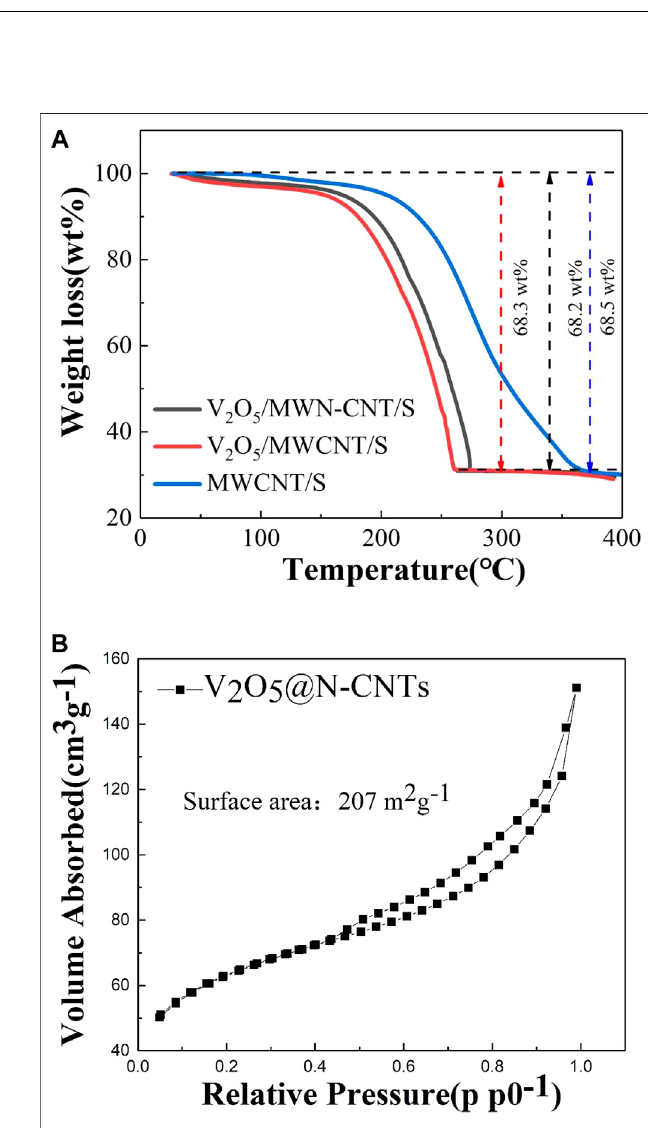
FIGURE 2 | SEM images of the nitrogen-doped V 2 O 5 /MWCNT/S composite materials, and EDS spectrum of the nitrogen-doped V 2 O 5 /S composite material.